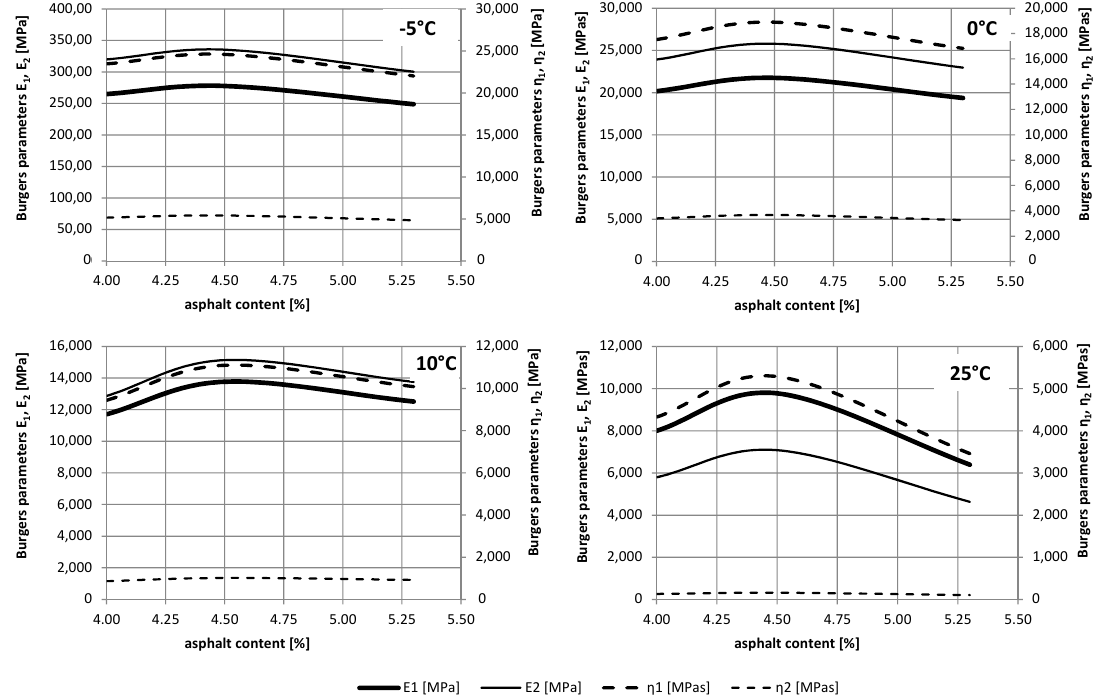
Figure 12. The relationship of Burgers parameters on the temperature in the dynamic test. For the temperature and asphalt content range analysed, changes in the parameters were